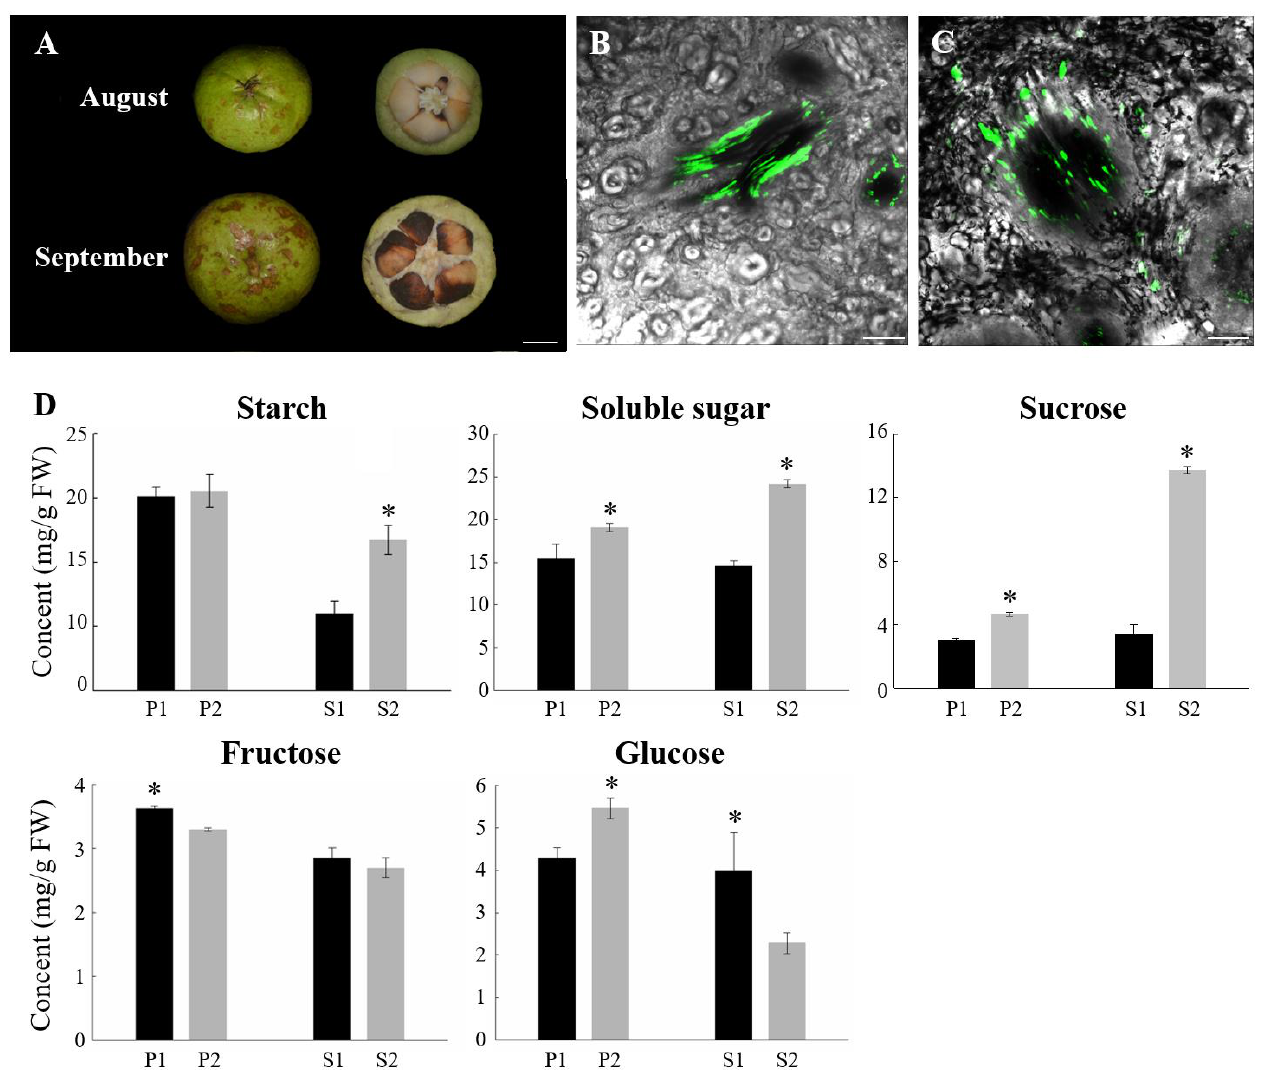
Figure 1. Physiological phenotype of oil tea fruit at two different developmental periods. ( A ) The fruit types used in the experiment. Bars = 1 cm; Confocal imaging of CF transport in phloem strands during oil tea fruit development. Transverse section of major vascular bundle in the fruit in August ( B ) and September ( C ). Bars = 250 μm; ( D ) Sugar concentrations in oil tea fruit at different stages. P1: pericarp in August; P2: pericarp in September; S1: seeds in August; S2: seeds in September. Bars represent the mean value of three replicates ± SD. Asterisk ( p < 0.05) indicate significant differences between two sampling periods.